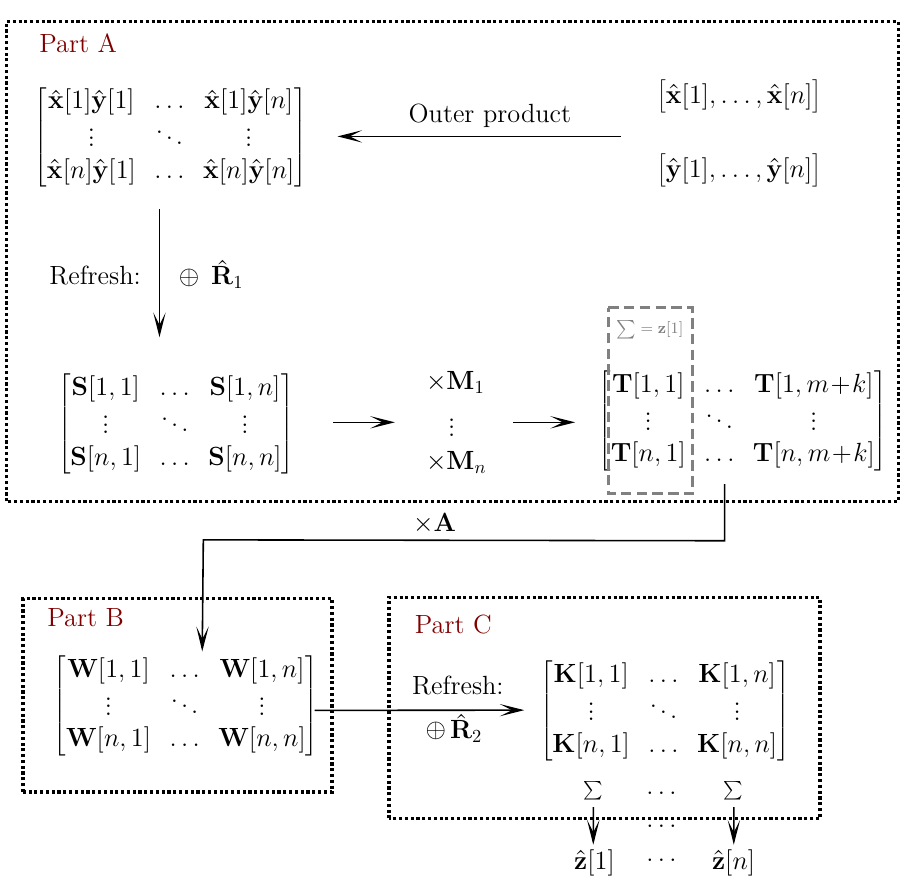
Figure 3: Illustration of the multiplication